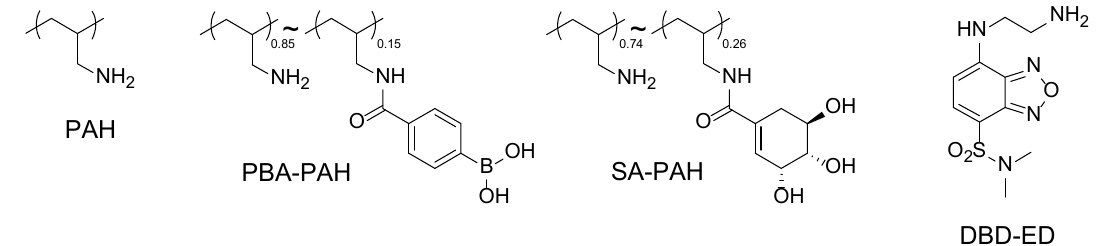
Figure 3. The chemical structures of the PAH, PBA-PAH, SA-PAH and DBD-ED.